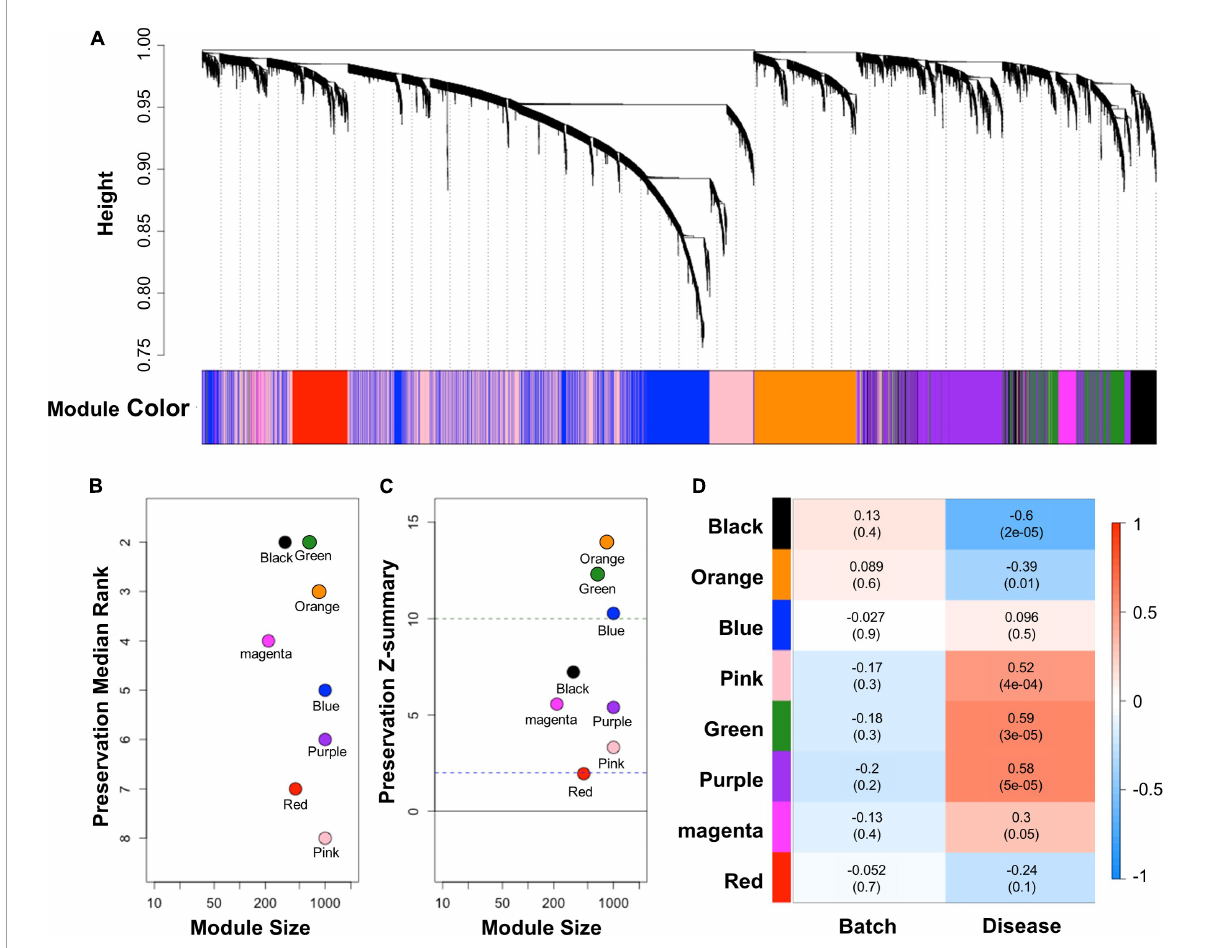
FIGURE3 Results of WGCNA and module preservation analysis. (A) Dendrogram showing the modules obtained from the signed network based on the dissimilarity of the topology overlap matrix of the AD modules. A total of eight modules were clustered and are represented by color. The modules were sorted by their respective module size and aligned by preservation median rank (B) and preservation Z -summary score (C) against cALD data. The dashed line at 10 indicates a strong preservation threshold, whereas the dashed line at 2 indicates no preservation threshold. (D) Matrix showing the correlation of characteristics of the samples in the merged cALD dataset and the genes in the modules. The numbers in parentheses are their respective p